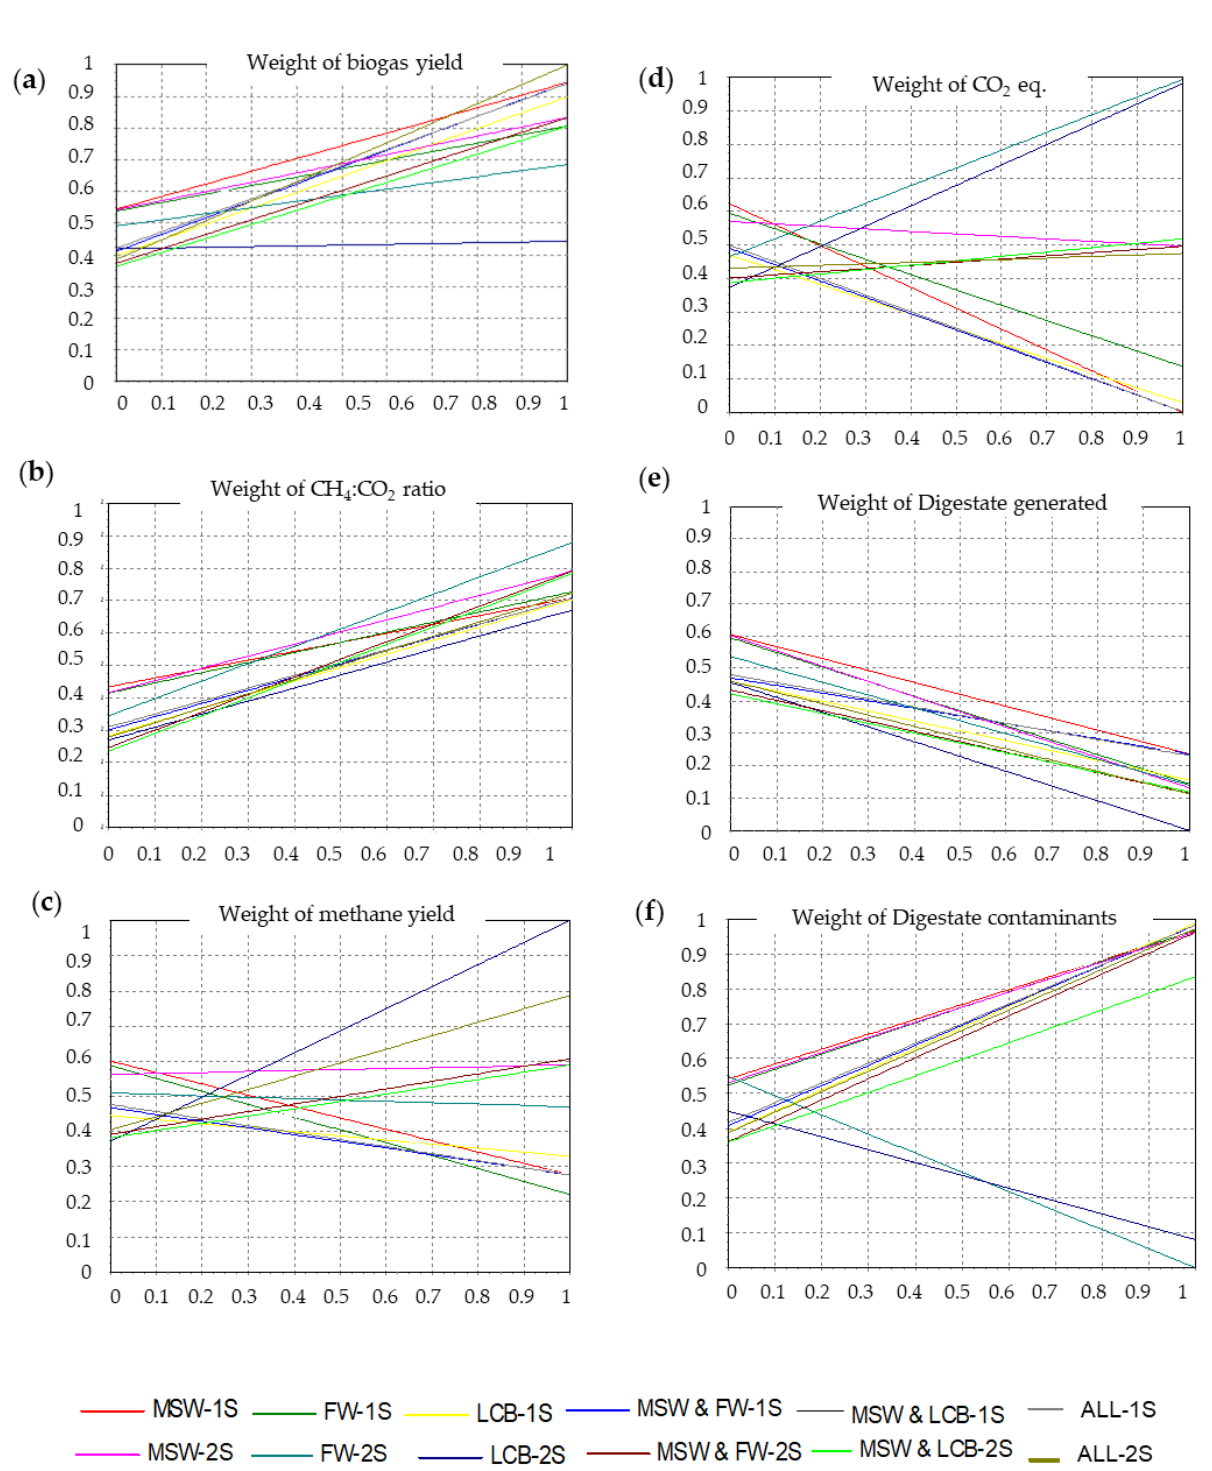
Figure 5. Sensitivity analysis of the ranking of the biogas plant alternatives to the weightings of the criteria: ( a ) biogas yield; ( b ) CH 4 :CO 2 ratio; ( c ) methane yield; ( d ) CO 2 eq.; ( e ); digestate generated; ( f ) digestate contaminants.